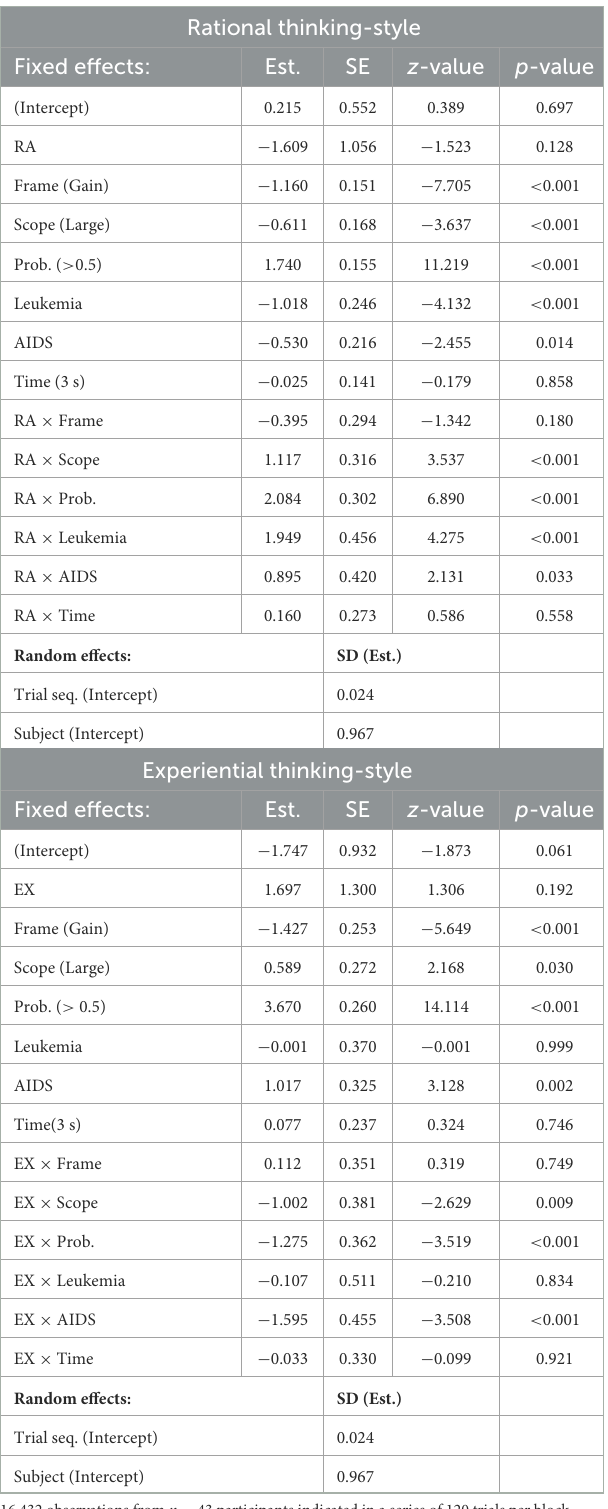
TABLE 2 Experiment 1: Generalized linear mixed models, Interactions: rational and experiential thinking-style. Rational